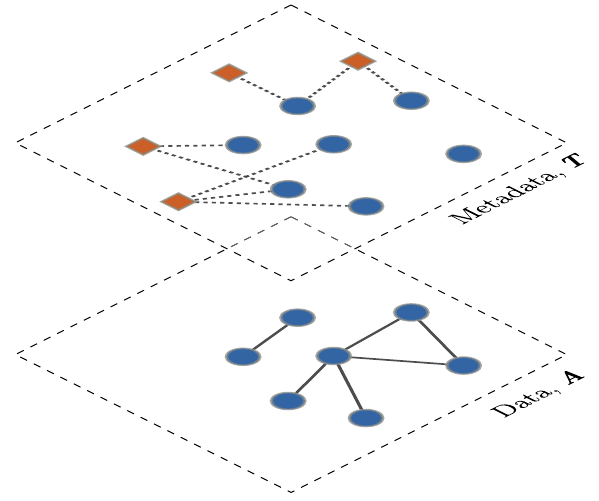
FIG. 1. Schematic representation of the joint data-metadata model. The data layer is composed of data nodes and is described by an adjacency matrix A , and the metadata layer is composed of the same data nodes, as well as tag nodes, and is described by a bipartite adjacency matrix T . Both layers are generated by two coupled degree-corrected SBMs, where the partition of the data nodes into groups is the same in both